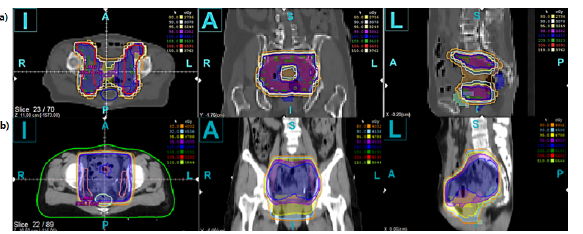
Fig 2. CT slice of IMRT (a) and cRT (b) radiotherapy plans with isodose lines (80%, orange; 95%, yellow; 100%, blue; 103%, green). Note that small bowel and rectum in IMRT plan are spared. (a) IMRT, Intensity-modulatedRadiotherapy. (b) cRT, Conventional